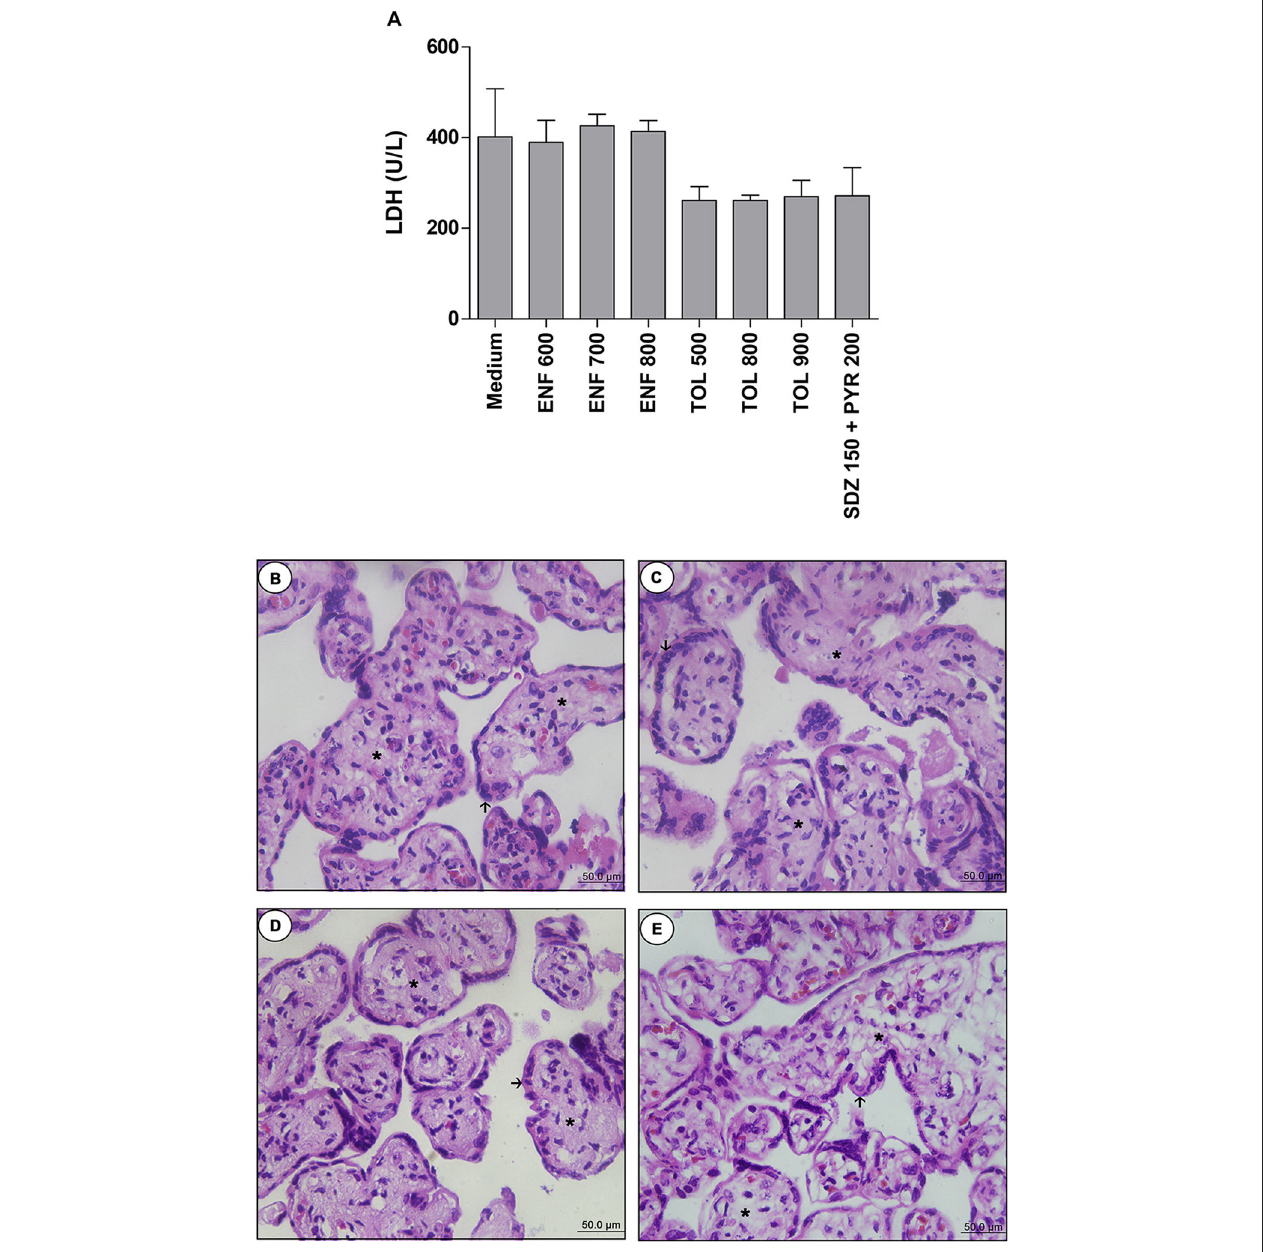
FIGURE 5 | Analysis of toxicity in human villous explants treated with different drugs.Villous explants were cultured during 24h in 96-well plates and treated or not with different drugs ( µ g/mL): enrofloxacin (ENF), toltrazuril (TOL) or combination of sulfadiazine plus pyrimethamine (SDZ + PYR). After 24h of treatment, supernatants were collected and lactate dehydrogenase (LDH) activity was measured using the LDH Liquiform Kit (A). Negative control was represented by villous treated with only RPMI medium. Data were expressed as mean ± SEM from three independent experiments in five replicates. Significant differences in relation to negative control (medium) ( # P < 0.05). Differences between groups were analyzed by One-Way ANOVA with the Kruskall Wallis Dunn’s multiple comparison post-hoc test. Representative photomicrographs of untreated villous explants (B) , or treated with ENF (700 µ g/mL) (C), TOL (900 µ g/mL) (D) , or combination of SDZ + PYR (150 + 200 µ g/mL) (E). Histological sections stained by hematoxylin and eosin. Arrows indicate the syncytiotrophoblast cells and asterisks(*) the mesenchyme. Bar scale: 50.0 µ m.